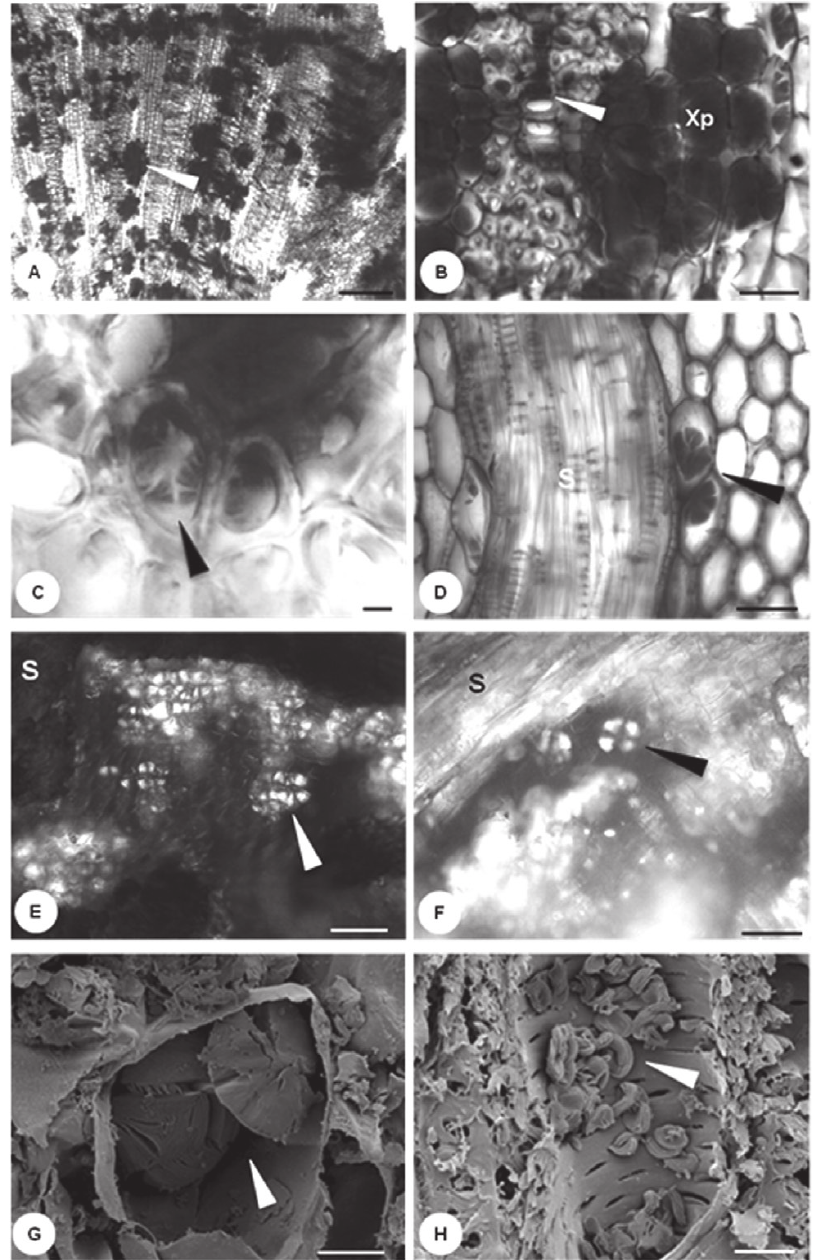
Fig. 4 - Transversal (A-D) and longitudinal sections (E, F) of the distal portion of the xylopodium of Dimerostemma vestitum . (A) Overview of xylopodium showing positive reaction of fructans to PAS reagent (arrow head); (B) Detail of fructans accumulated in the xylem parenchyma cells (Xp) and vessel elements (arrow head); (C, D) Details of inulin accumulation (arrow heads) inside vessel elements (C) and in the parenchyma cells (D); (E, F) Inulin sphero-crystals viewed under polarized light (arrow heads) in parenchyma cells; (G, H) Scanning electron microscopy of inulin particles (arrow heads) accumulated in the parenchyma cells (G) and in vessel elements (H). Sclereids (S). Scale bars: 1000 µm (A); 100 µm (B, C, D); 250 µm (E, F); 10 µm (G); 5 µm